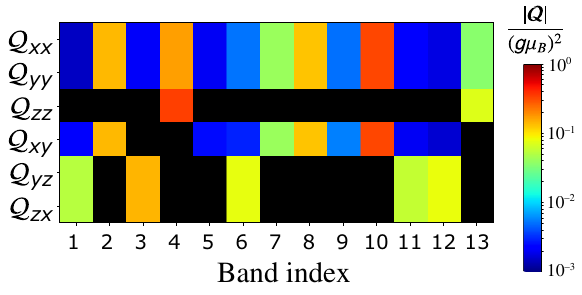
FIG. 10. Magnetic quadrupole moment Q of low-energy magnon modes in SkXs. The dimensionless amplitude of Q /( g μ ) 2 is plotted on a logarithmic scale, obtained at D / J = B 0.5 and g μ B B z J /( D 2 S ) = 0.8. Black regions indicate dipole moments smaller than 10 − 3 . See Table I for the description of magnon modes.